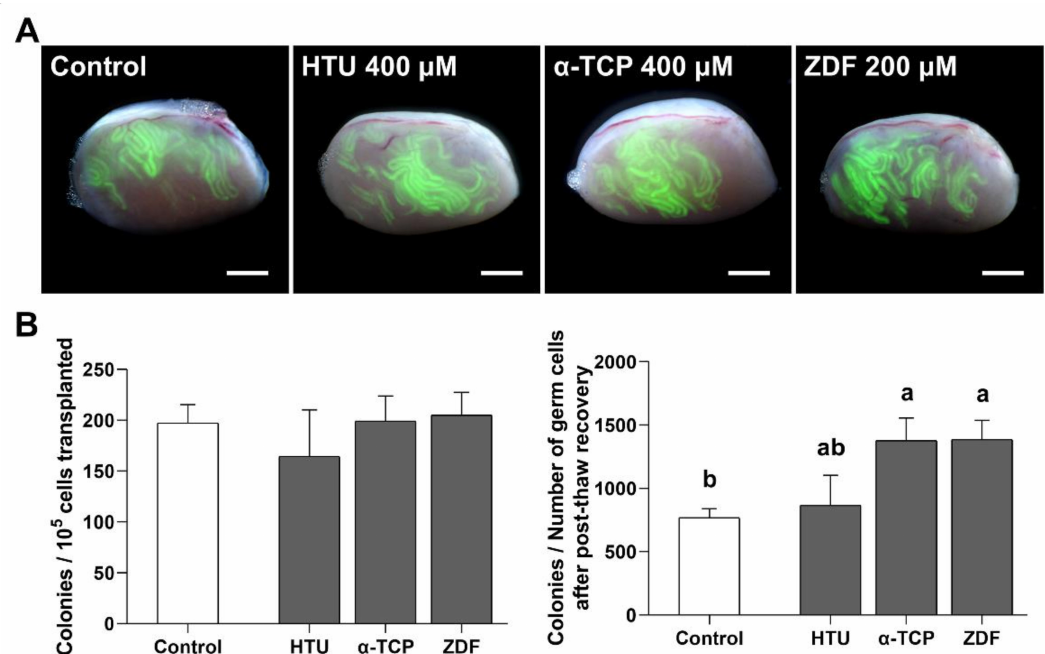
Figure 5. Functional activity of SSCs after post-thaw recovery with antioxidant or apoptosis inhibitor supplementation. ( A ) Merged bright/dark-field fluorescence images of C57 recipient testes after in vivo transplantation. Colonies derived from the donor C57-GFP + SSCs are formed in seminiferous tubules, which are distinguished in the C57 recipient mice. Scale bar = 2 mm. ( B ) Number of colonies per 10 5 cells transplanted and number of colonies per recovered germ cells after post-thaw recovery and culture. Total number of mice/testes used for analysis was 8/13, 8/11, 8/15, and 8/13 in the control, HTU 400 µ M, α -TCP 400 µ M, and ZDF 200 µ M groups, respectively. Non-injected testes with a poor condition were excluded from testis analysis. Values are expressed as mean ± SEM ( n = 13, 11, 15, and 13 testes, respectively). A statistically significant difference ( p < 0.05) is represented by different letters above each